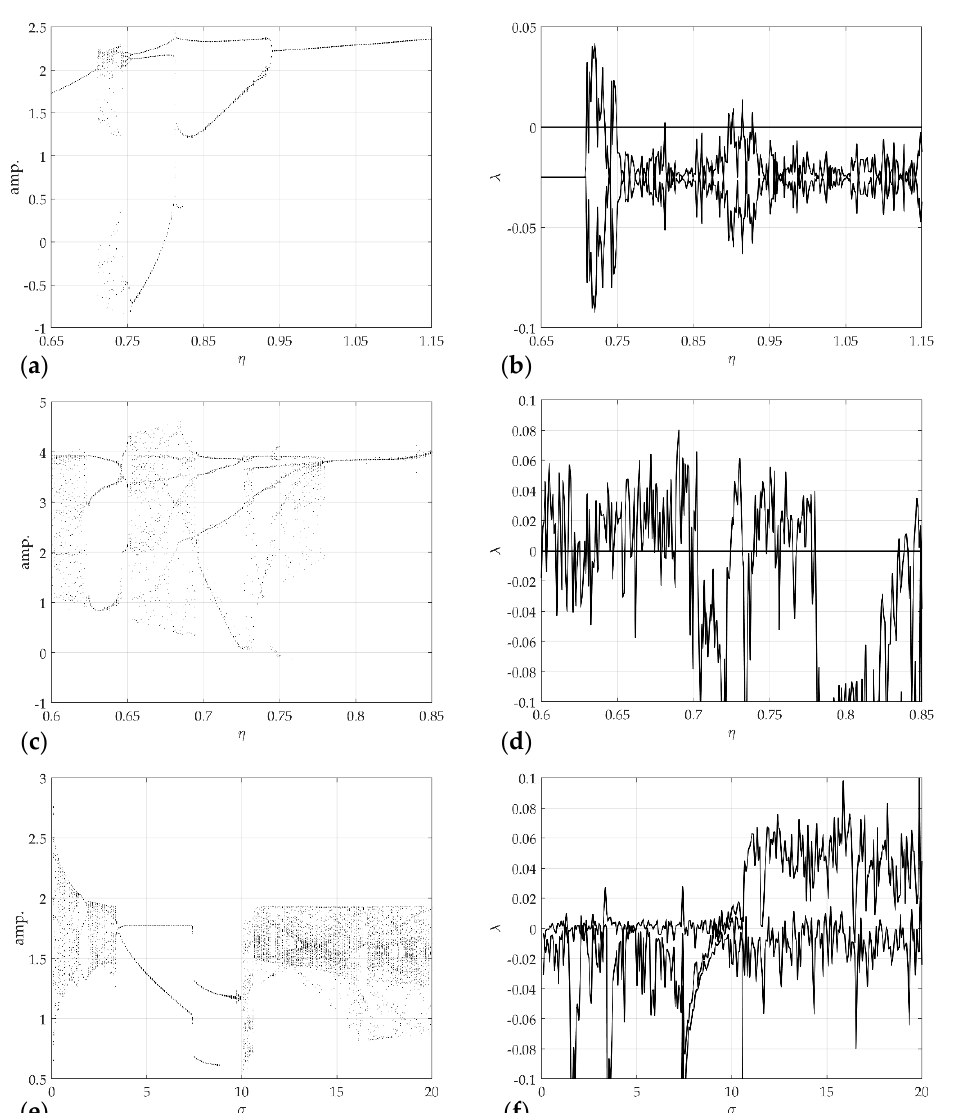
Figure 11. Chaotic analysis for the S&R model: ( a ) bifurcation diagram of displacements; ( b ) largest Lyapunov exponent, for rattle model with respect to η ; ( c ) bifurcation diagram of displacements; ( d ) largest Lyapunov exponent, for single-mode squeak model with respect to η ; ( e ) bifurcation diagram of displacements; ( f ) largest Lyapunov exponent, for multi-modes squeak model with respect to σ